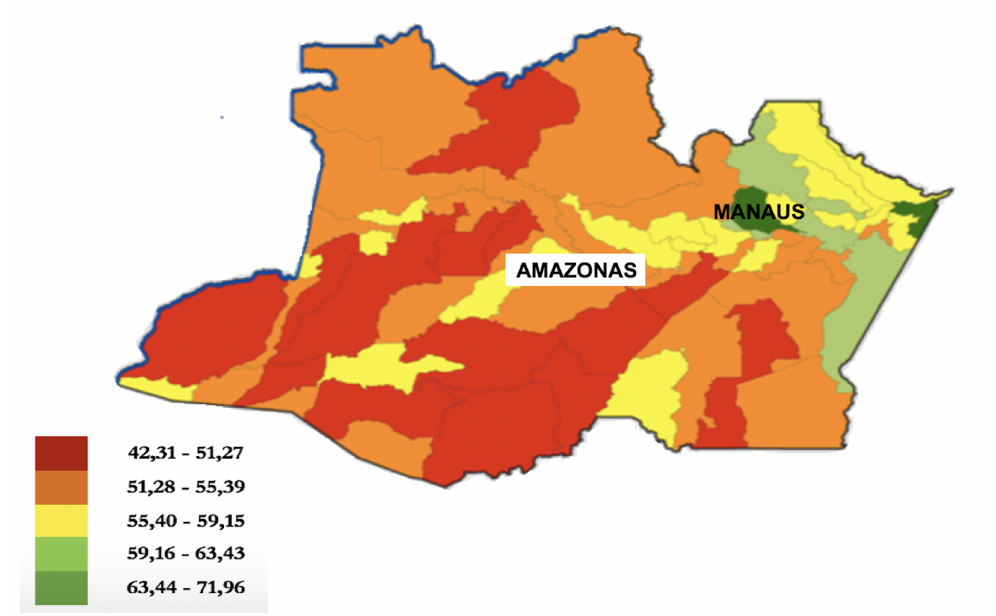
Figure 1: Social Progress Index in the state of